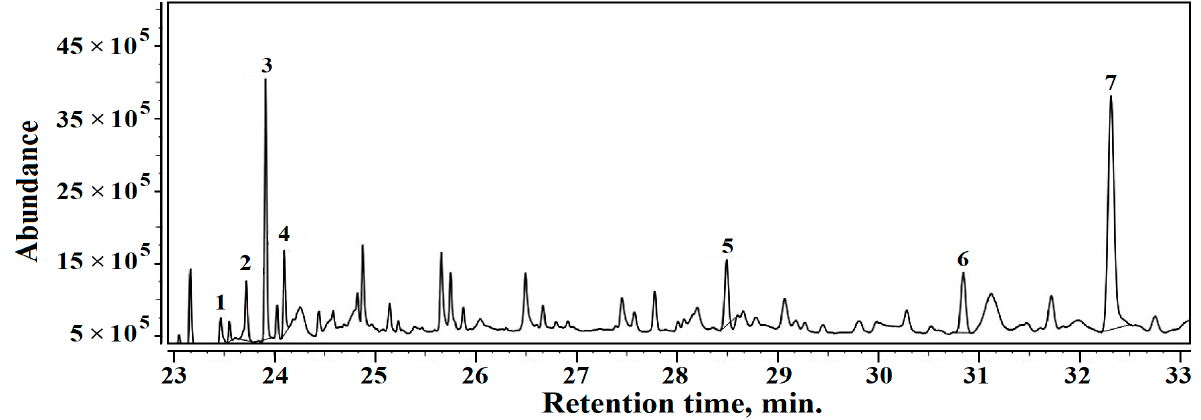
Figure 10. TIC chromatogram results for organic fraction within Sample 2.